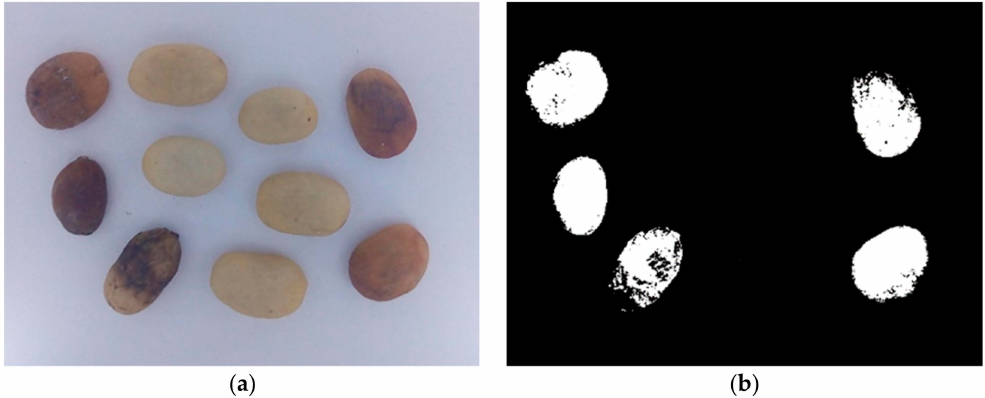
Figure 8. Images ( a ) without segmentation and ( b ) with segmentation by color